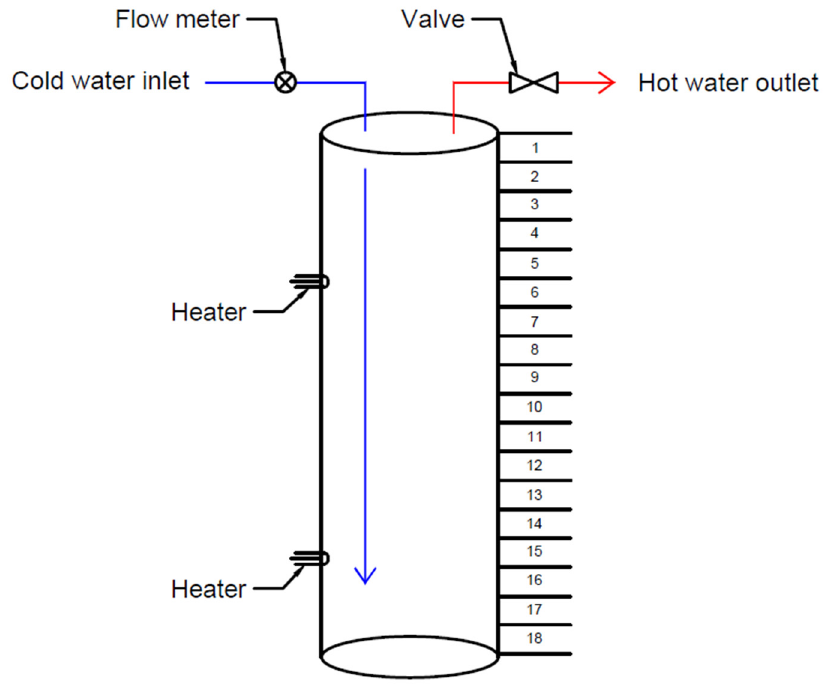
Figure 19. The tank used for the simulation study by Najafian et al. Adapted with permission from ref. [140] 2015 Najafian et al. Table 7. A few studies on the integration of TES systems on solar water tanks.